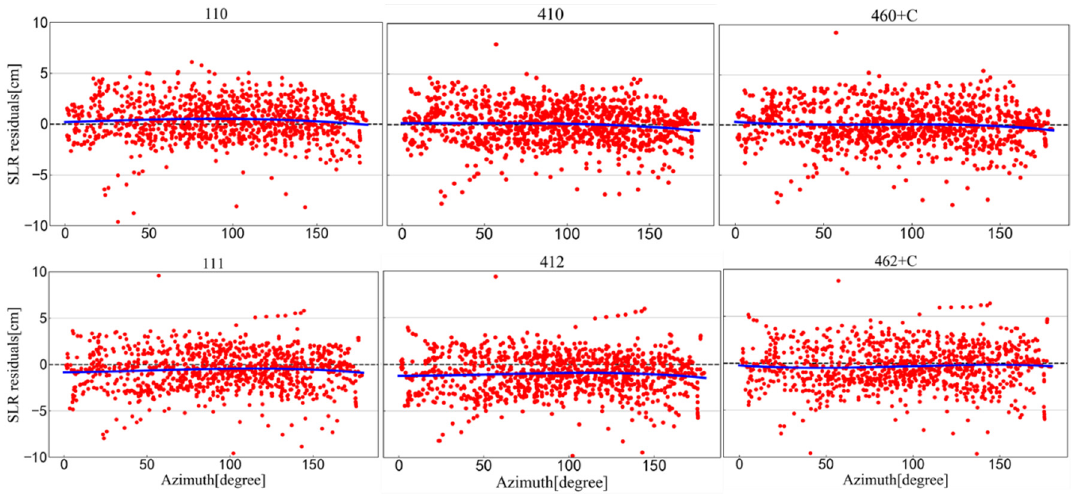
Figure 4. SLR residuals (red dot) obtained for the six PEA solutions with respect to the azimuth angle for all sites. A trend line (blue) is fitted with polynomials.